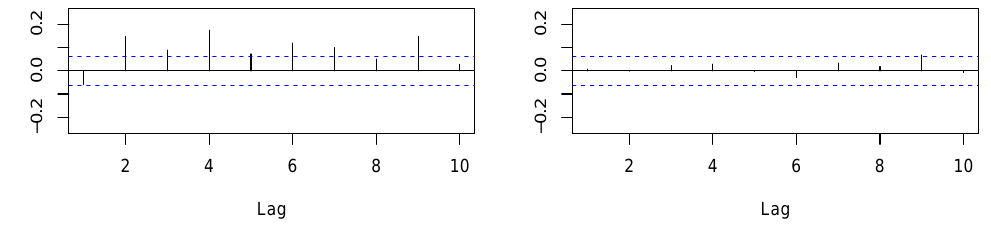
Figure 5. (cid:98) L t , in-sample autocorrelations of AR(1) residuals ( left ) and their squares ( right